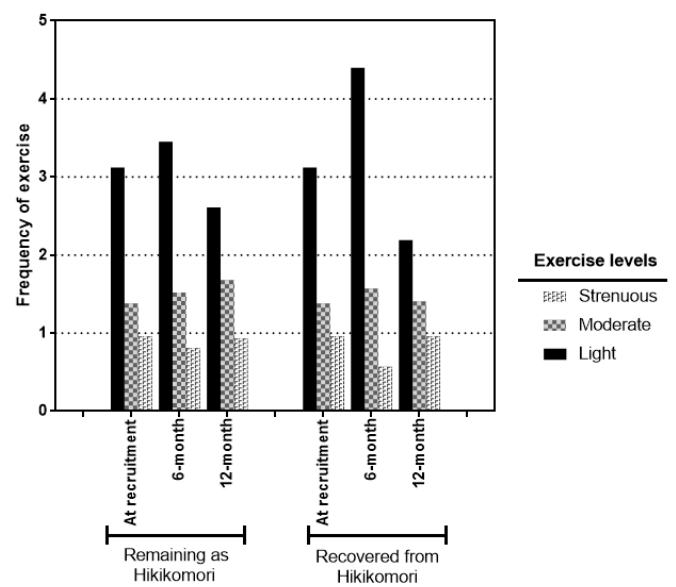
Figure 3. The frequencies of different intensity levels of exercise practiced by participants remained as hikikomori and those recovered.